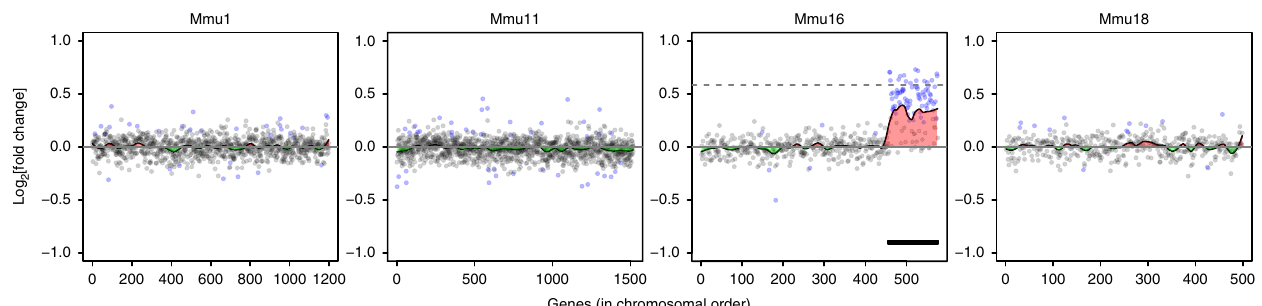
Fig. 5 Change in expression in Dp1Tyb hippocampus as a function of chromosomal position. Plots show fold change of gene expression in Dp1Tyb vs wild- type hippocampus. Expressed genes are plotted in chromosomal order on the four example chromosomes. Genes that are signi fi cantly differentially expressed are indicated with blue dots, other genes are in grey. A Loess smoothing curve is superimposed with regions that are upregulated or downregulated indicated in red or green, respectively. Dashed line on Mmu16 plot indicates a fold change of 1.5. Note the upregulation of genes in the duplicated region on Mmu16 (thick black